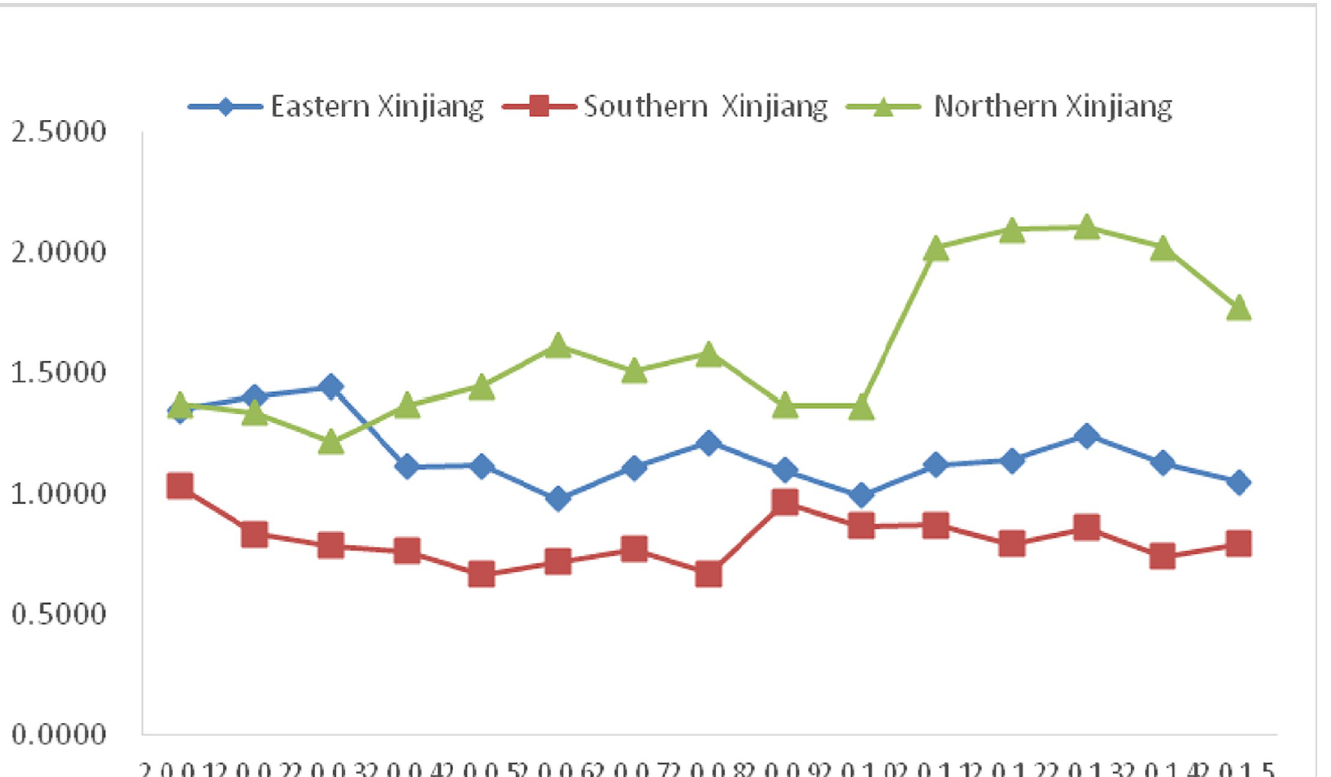
frontier of efficient production, while Southern Xinjiang is lower than 1.00, which is an inef-